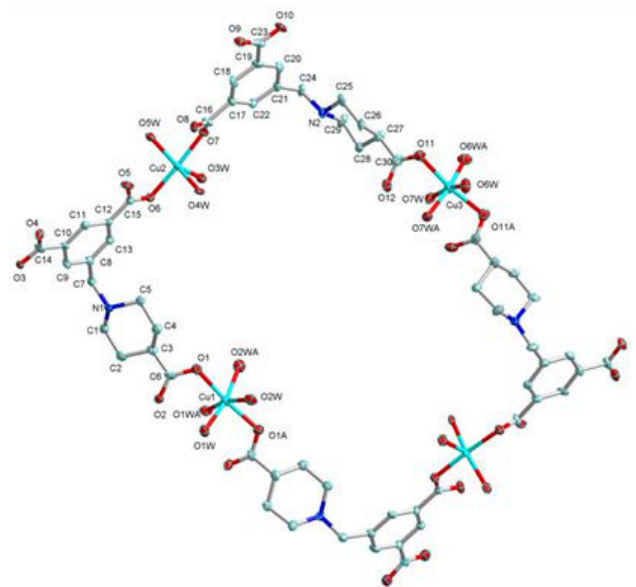
Figure 1. The coordination environment of Cu(II) in complex 1 with ellipsoids drawn at 30% probability level (Symmetry codes: (A) 1 − x , y , 5/2 − z ).